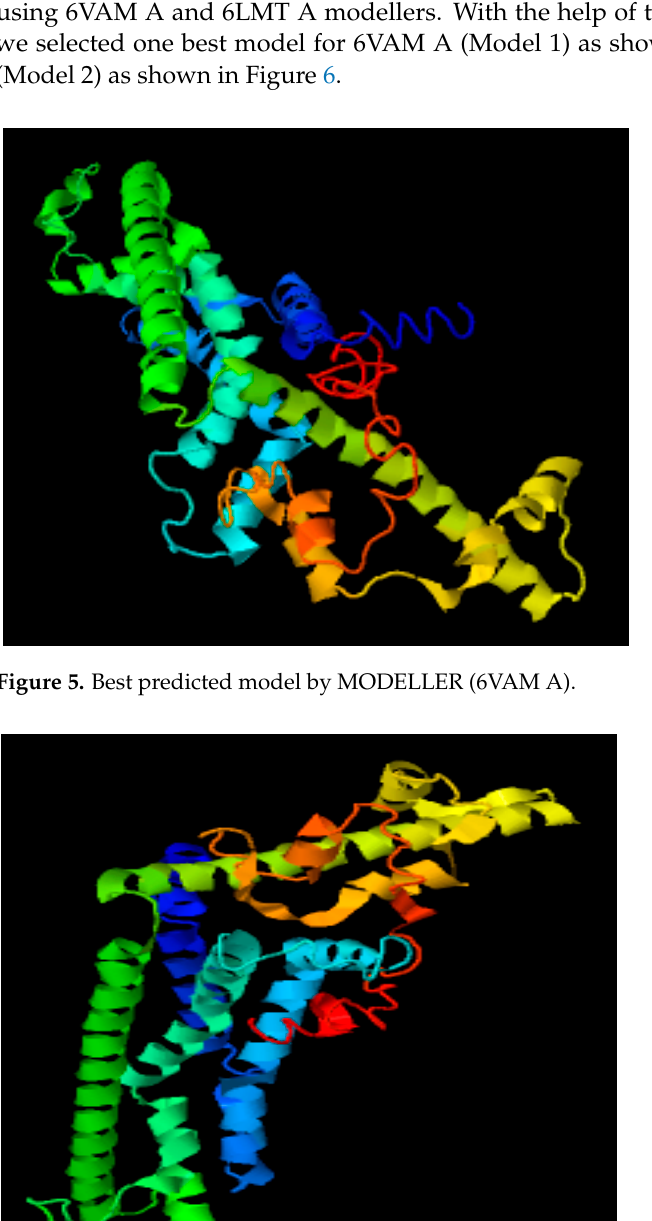
Figure 7. Best predicted model by LOMETS. 3.6. Protein Structure Prediction Using MUSTER Server In addition, the MUSTER online server was used for protein treading. This server created ten different protein sequence models, among which the structure with the low- est Z-score and the maximum coverage was chosen as the fittest structure as shown in Figure 8.